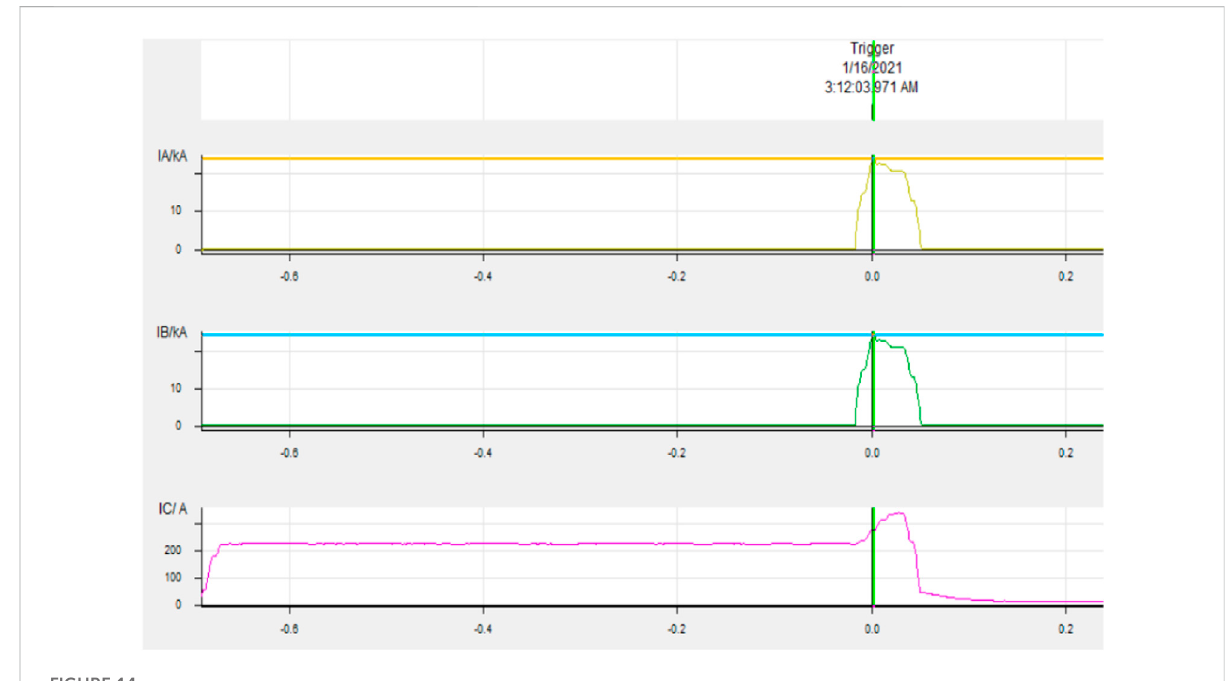
Three phase current after phase-to-phase fault